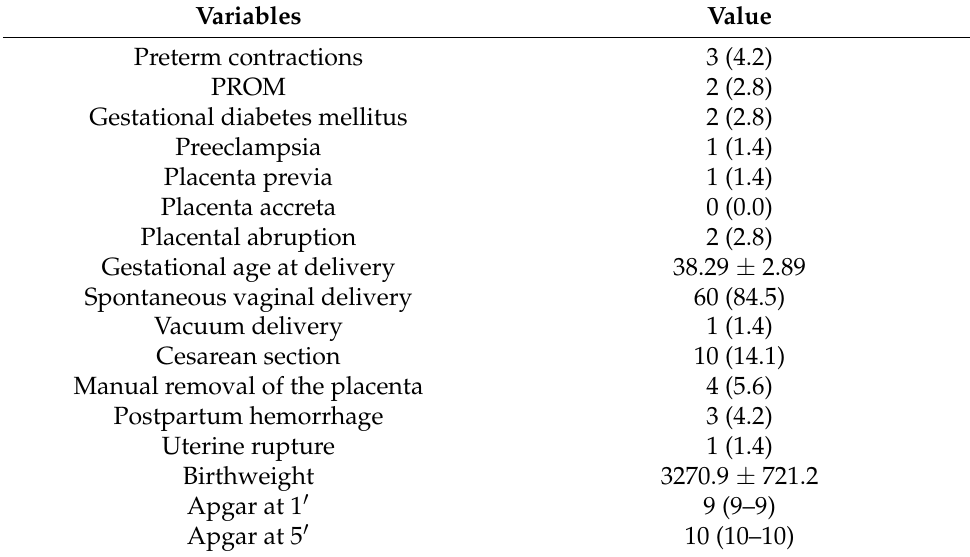
Table 4. Pregnancy complications and obstetric outcomes among patients following perforation of